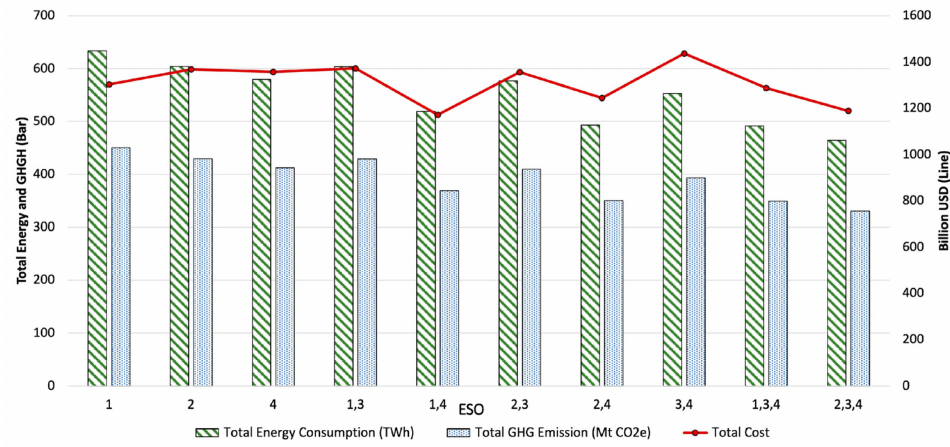
Figure 10. Energy reduction, GHG reduction, and investment required from communities by 2050 under ideal